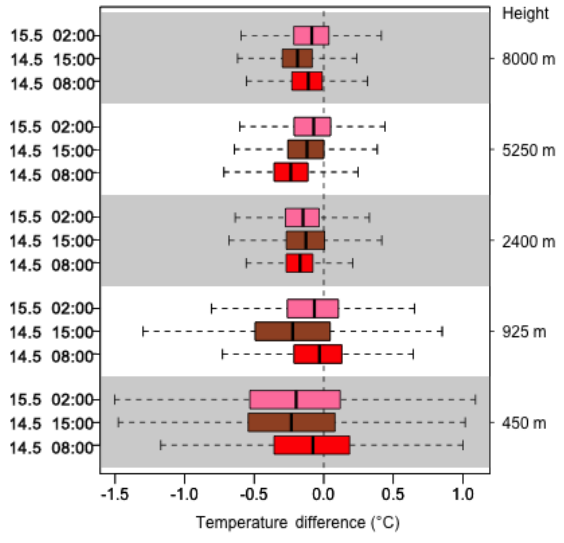
Figure 12. Temperature differences between HR and HR_RESHIFT in domain